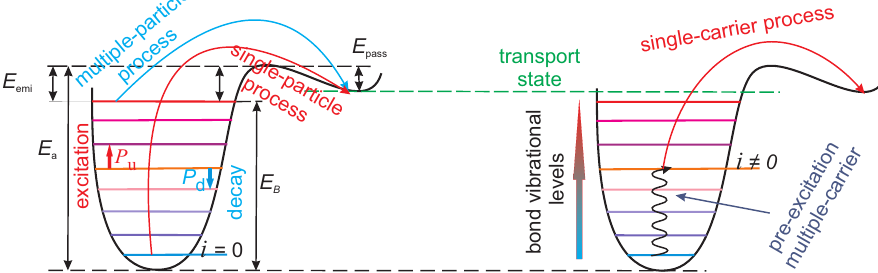
Figure 2. Single- and multiple-carrier mechanisms of Si-H bond rupture (left panel) and their superposition (right